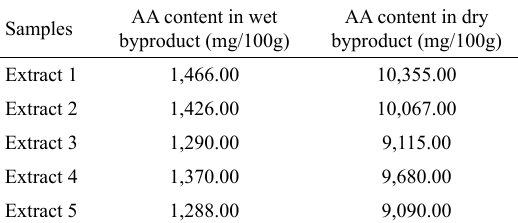
Table 2. AA content in the agroindustrial byproduct of acerola.